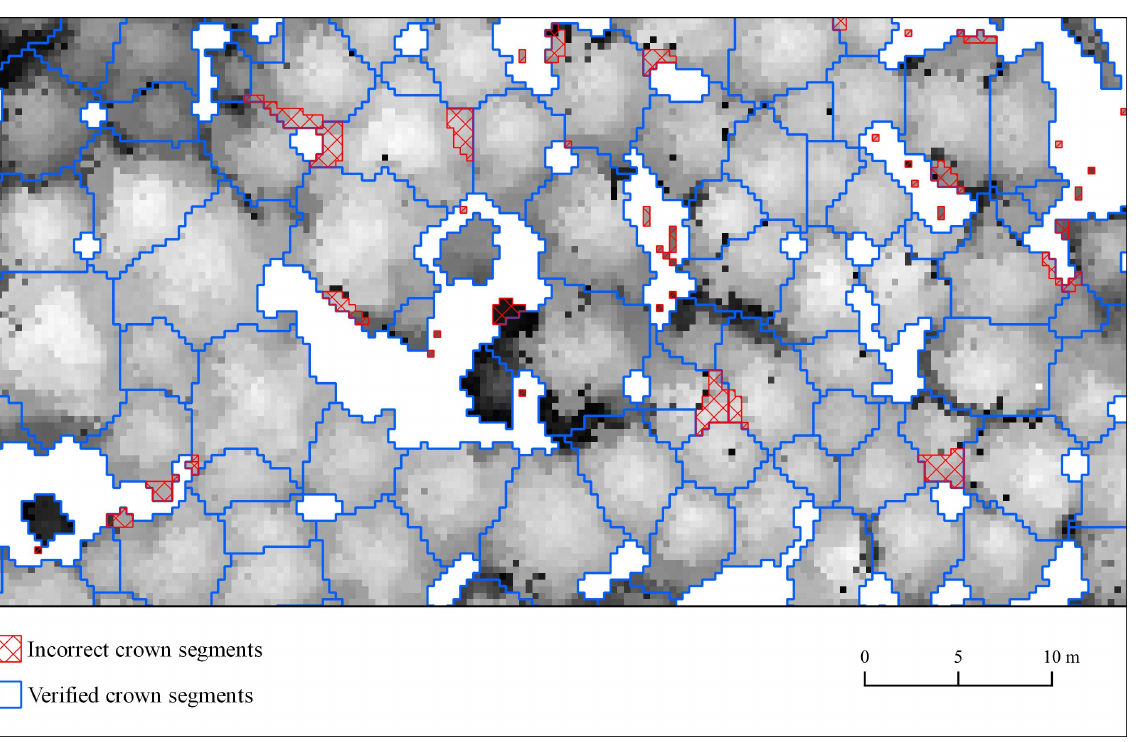
Figure 7. An exemplary execution result of the post-processing correction procedure after applying one of the automatic tree detection